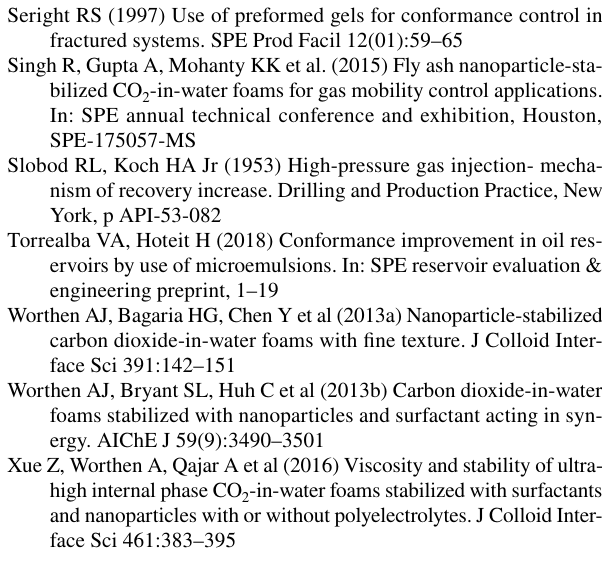
Figdore PE (1982) Adsorption of surfactants on kaolinite: NaCl versus